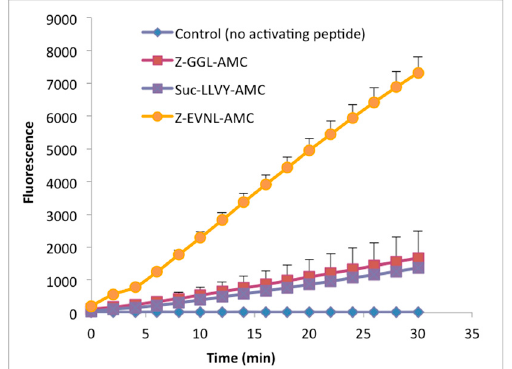
Figure 2. Degradation of different fluorogenic substrates by LmHslV. LmHslV (75.2 nM) was incubated at 37 °C with different fluorogenic substrates (100 μ M) in the presence of the activating peptide LmC12-U2 (500 μ M). The fluorescence of the free AMC group, proportional to the activity of the sample, was measured at 2 min. intervals. With each substrate, no activity was measured in the absence of activating peptide: for the sake of clarity, only the negative control values obtained with the substrate ZGGL-AMC are shown.